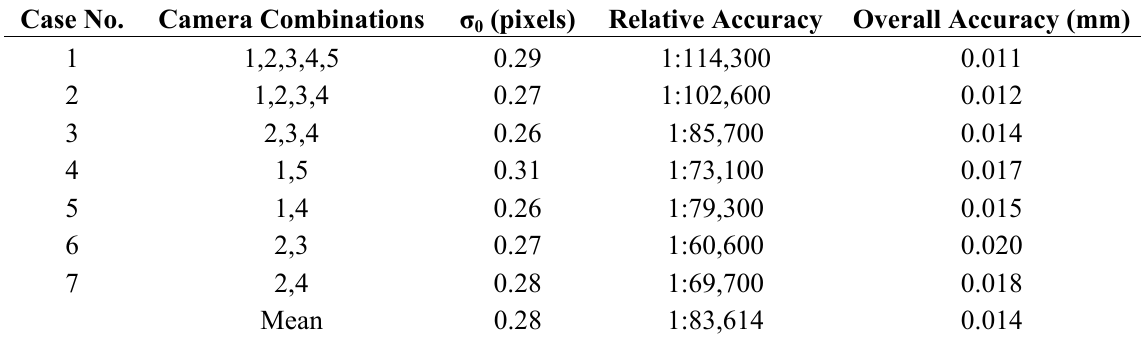
Table 2. Summary of accuracy analysis results after photo-triangulation for different camera combinations.